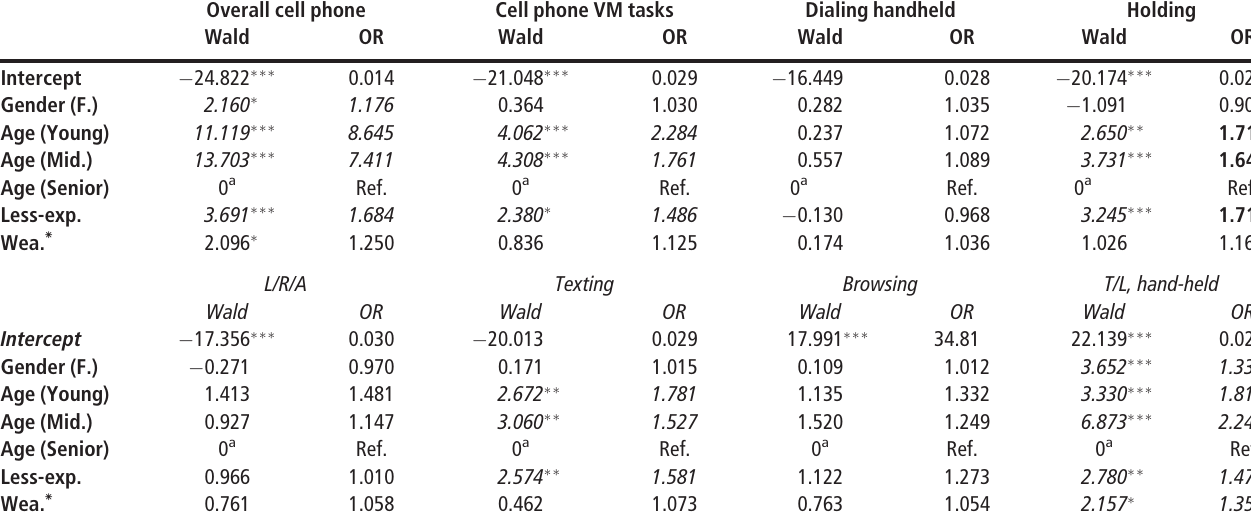
Table VI Mixed effect of logistic regression model results regarding the likelihood of cell phone engagements Overall cell phone Cell phone VM tasks Dialing handheld Holding